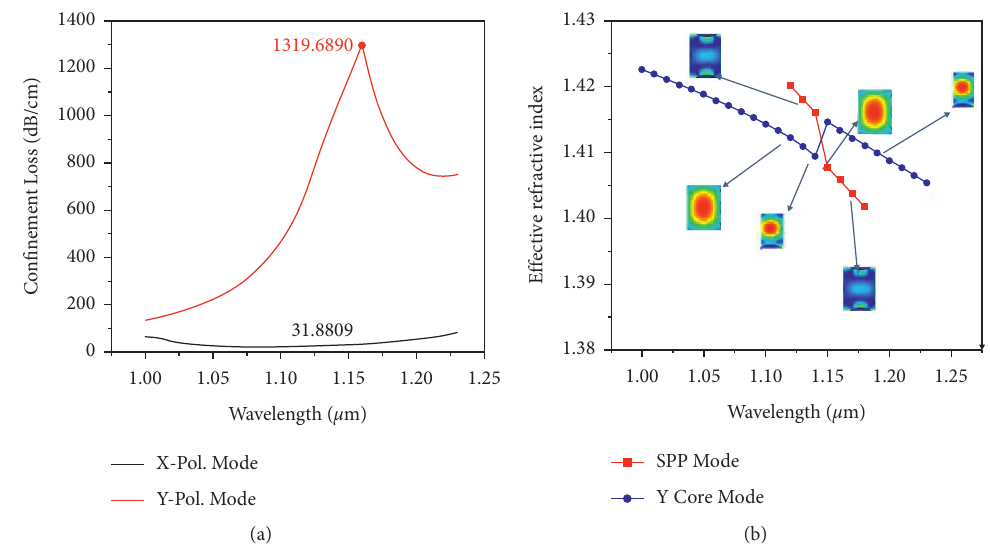
Figure 2: Dispersion relations of the y-polarized core modes and SPP